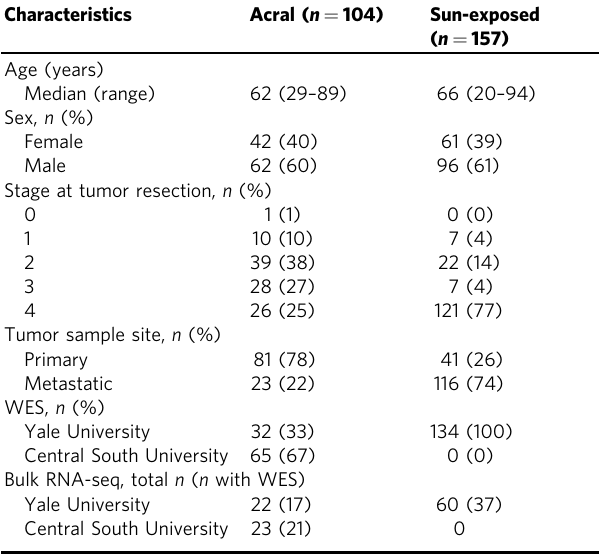
Table 1 Patient characteristics and sequencing